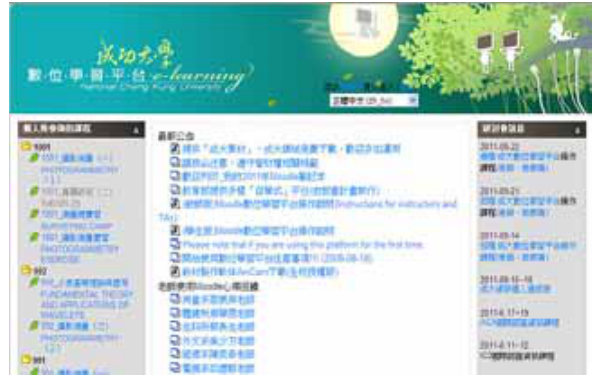
Figure 5. Front page of the NCKU Moodle system for selecting three photogrammetry-related e-learning courses